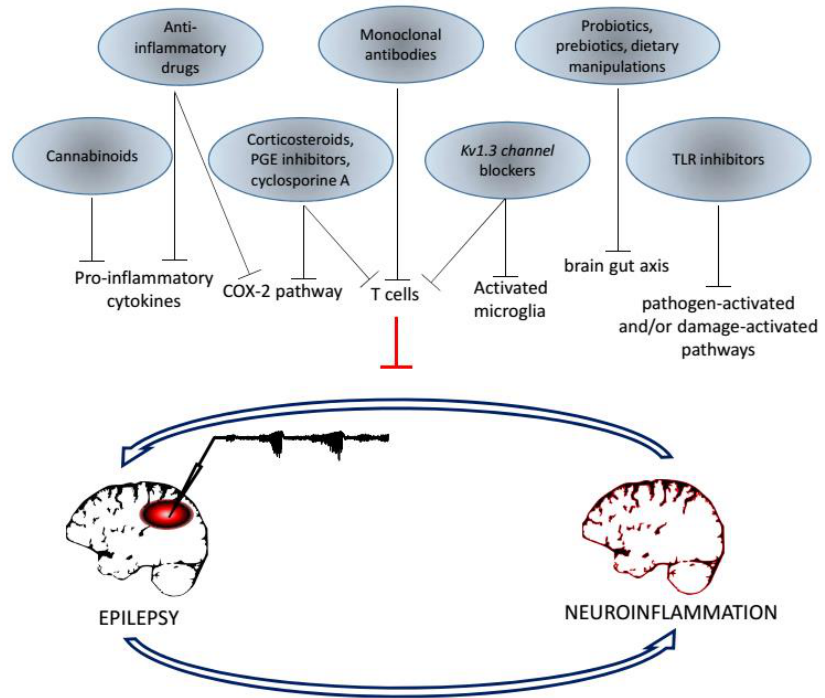
Figure 3. Schematic representation of attempted therapeutic strategies targeting neuroinflammation and capable to ameliorate epilepsy. The diagram illustrates the interaction with specific families of drugs and their targets; their main function seems to interrupt the loop that reinforces neuroinflam- mation produced by epileptogenesis. The trace recorded from the left brain is a typical example of critical activity due to the localized treatment with the convulsive agent 4-AP in our experiments, as conducted in [152].